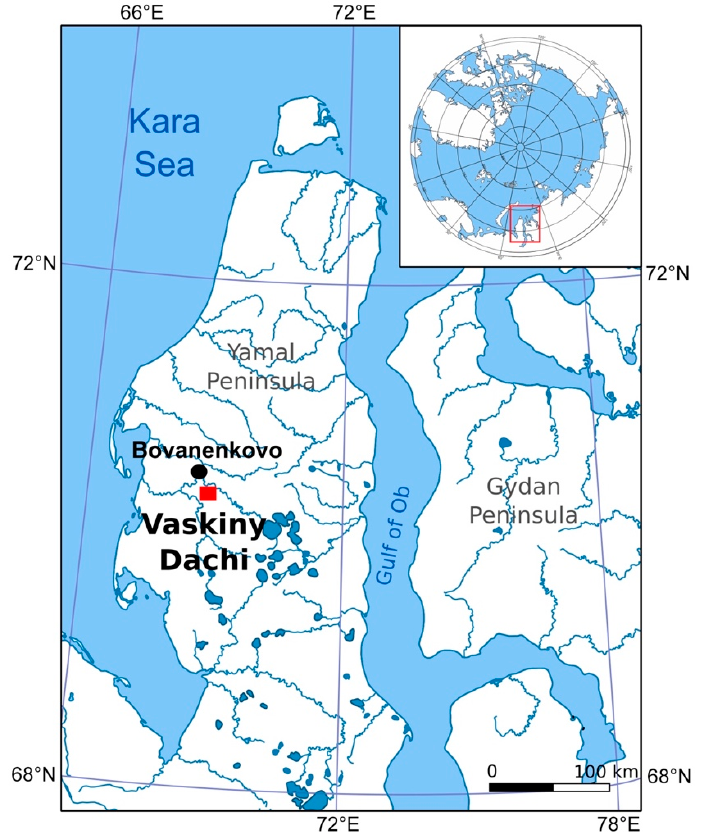
Figure 1. Study area map showing the location of the study key site.